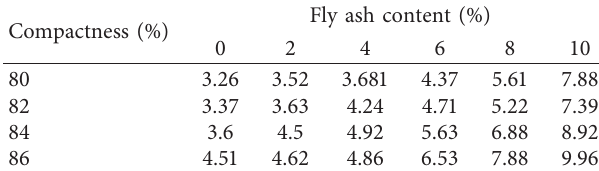
Table 2: Compressive modulus of fly ash modified soil with dif- ferent compaction degrees (MPa).